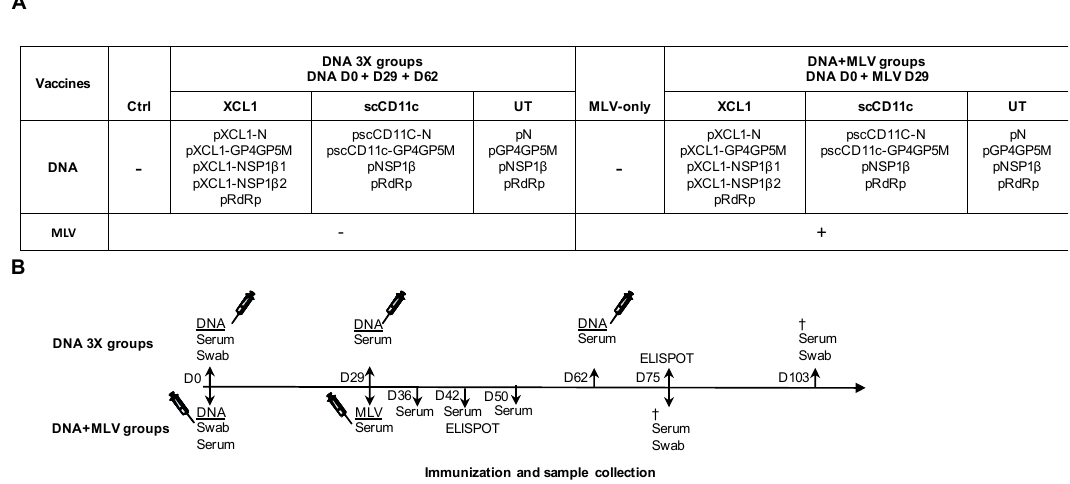
Figure 2. Immunization protocol with DNA-only (DNA 3X) and with DNA-MLV prime–boost (DNA + MLV). ( A ) One-month-old pigs (eight per group) of the DNA 3X and DNA-MLV groups received 400 µg of the plasmids listed in the table, on the same day (D0). The plasmids were formulated with PLGA NPs and delivered intradermally using surface electroporation. The groups are named under the VB type used to target DC (XCL1 or scCD11c), the untargeted antigens (UT) or under controls (not immunized). Note that, in all groups, pRdRp used as RdRp could not be targeted, and in the scCD11c group, pNSP1 β coding for UT NSP1 β was used. On D29 and D62, the DNA 3X groups were boosted with the same DNA plasmids as on D0. On D29, the four DNA + MLV groups were injected with MLV-FL13b (10 5.5 TCID 50 per pig) intramuscularly. ( B ) The sampling and immunization schedules are reported on the time line: blood was collected on CPT tubes for ELISPOT assay on D42 and D75 (DNA group and DNA + MLV group, respectively, 13 days after boost). The DNA + MLV groups were euthanized on D75 and the DNA 3X on D103. The sera were collected on D0, D29, D62, and D103 in the DNA 3X groups and on D0, D29, D36, D42, D50 and D75 in the DNA + MLV groups. Nasal swabs were collected on D0 and D103 in the DNA groups and on D0 and D75 in the DNA + MLV group.